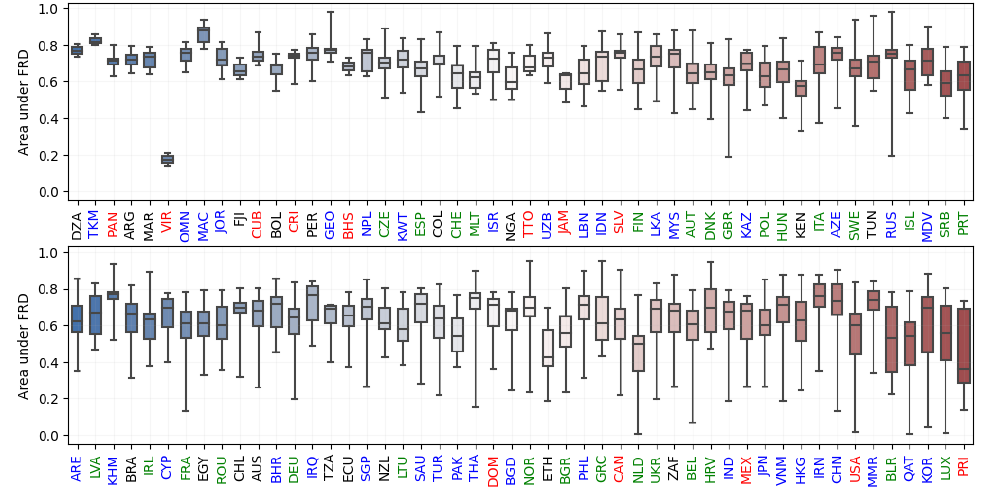
Figure 7. Range of area under FRD for all countries in this